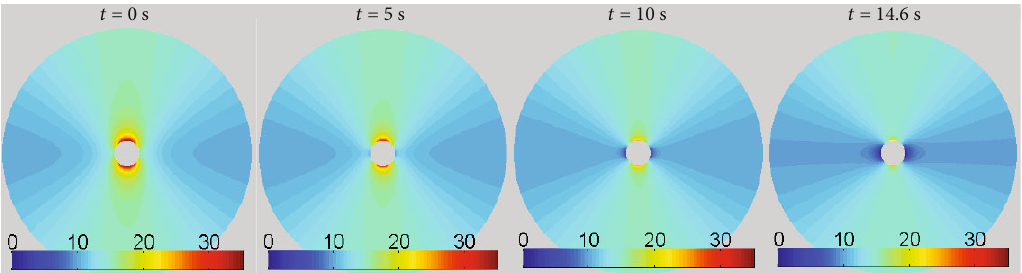
Figure 3: Wellbore breakdown process for impermeable rock case.